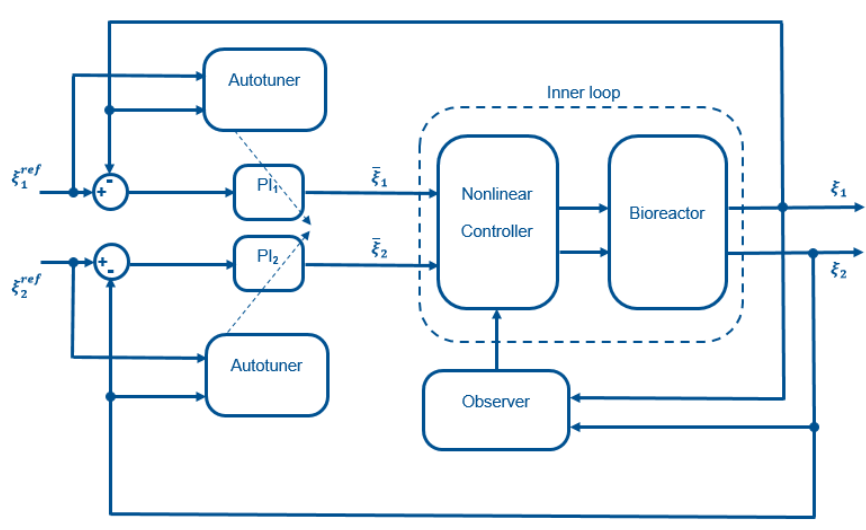
Figure 2. Schematic representation of the control